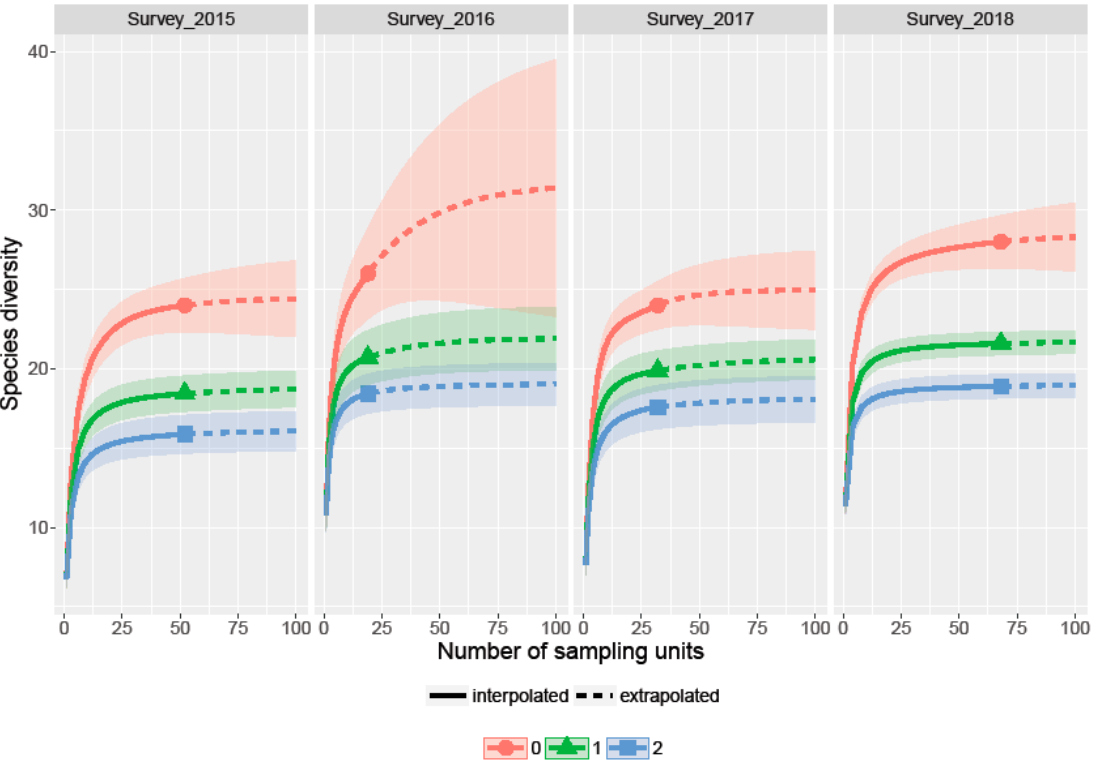
Figure 3. Incidence based diversity estimates with respect to sample coverage (Hill numbers) in the four survey years showing: Upper line (0) Species richness, middle line (1) the exponential of Shannon’s entropy index and lower line (2) the inverse of Simpson’s concentration index.